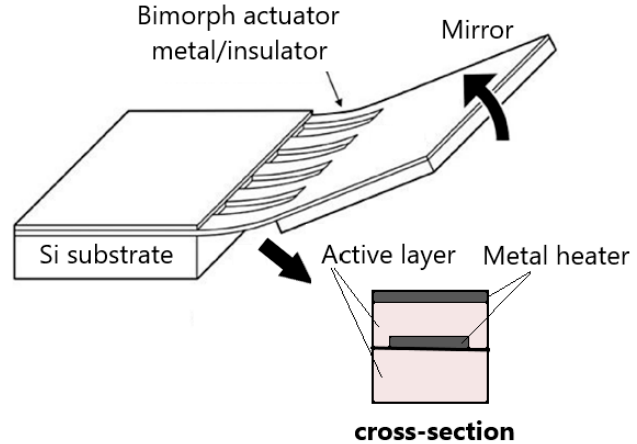
Figure 19. Principle of electrothermal actuation.